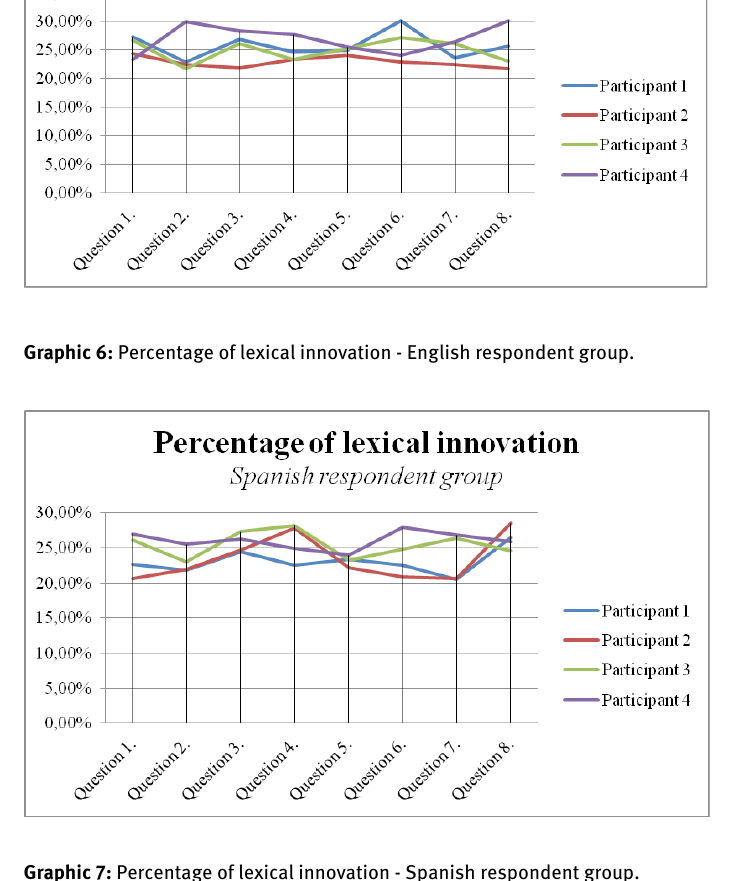
Graphic 7: Percentage of lexical innovation - Spanish respondent